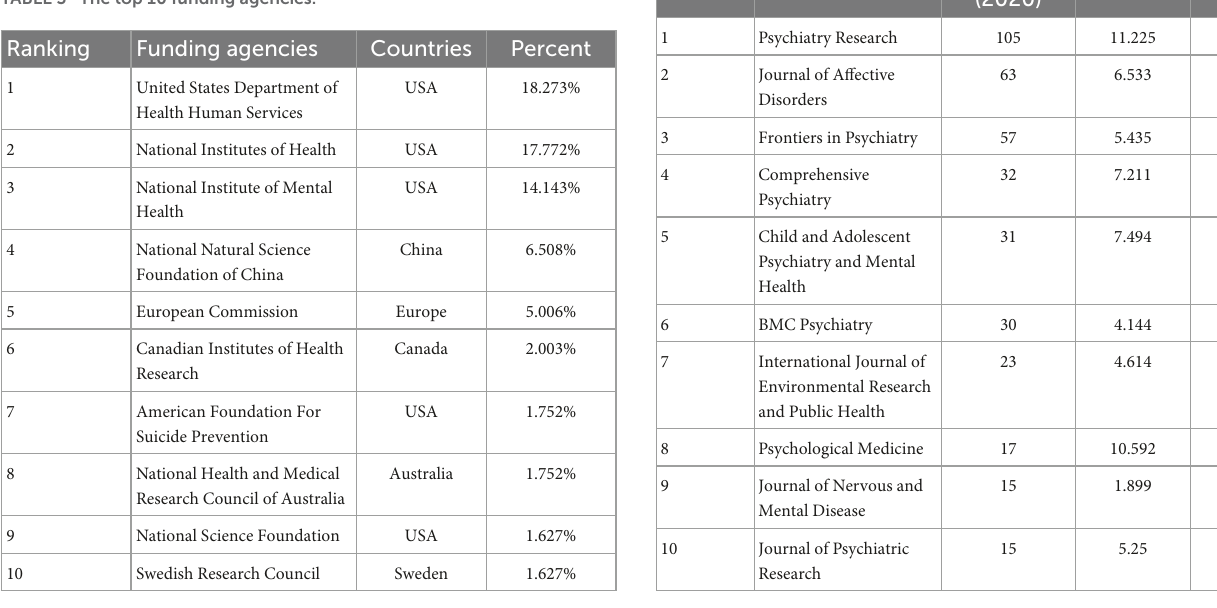
occurrence; and the line connecting the elements denotes the co- cited relationship. The size of the element is proportional to the citation count of the reference (32). As shown in Figure 10 , cluster #0 (community sample), #8 (diagnostic correlate) and #9 (sexual abuse) started earlier; while cluster #4 (eating disordered behavior), and #6 (non-suicidal self-injury) are still continuous, which could be regarded as the frontier.